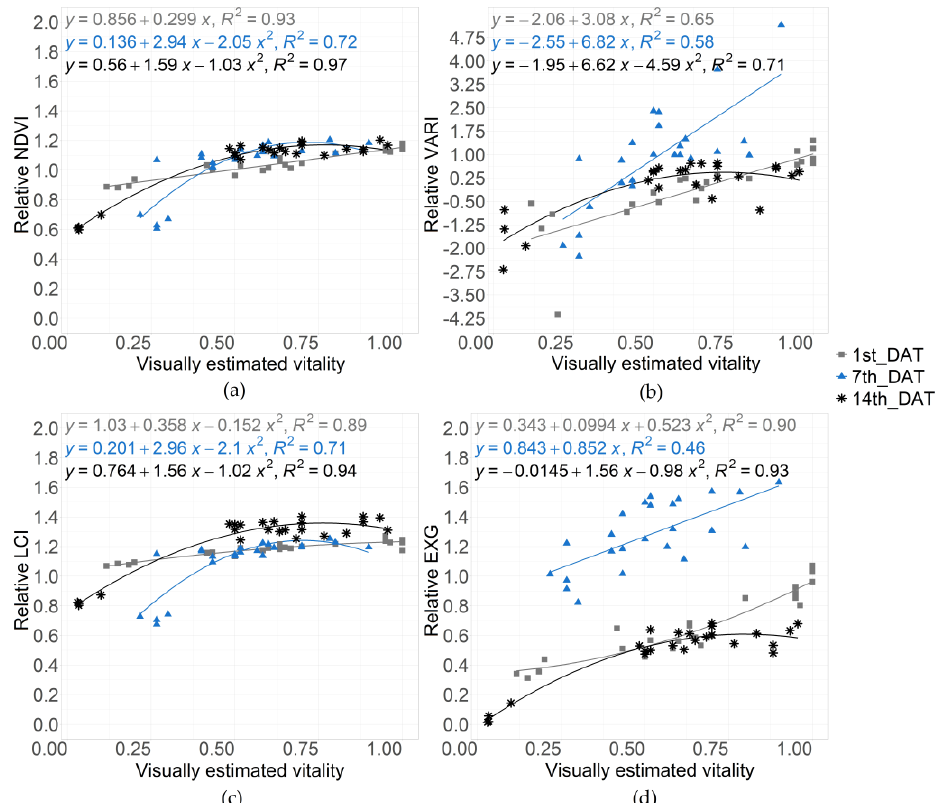
Figure 9. ( a − d ): Relationship between VIs (relative values compared with before application) and visually estimated vitality in 2021. Linear and polynomial regression analysis ( p <